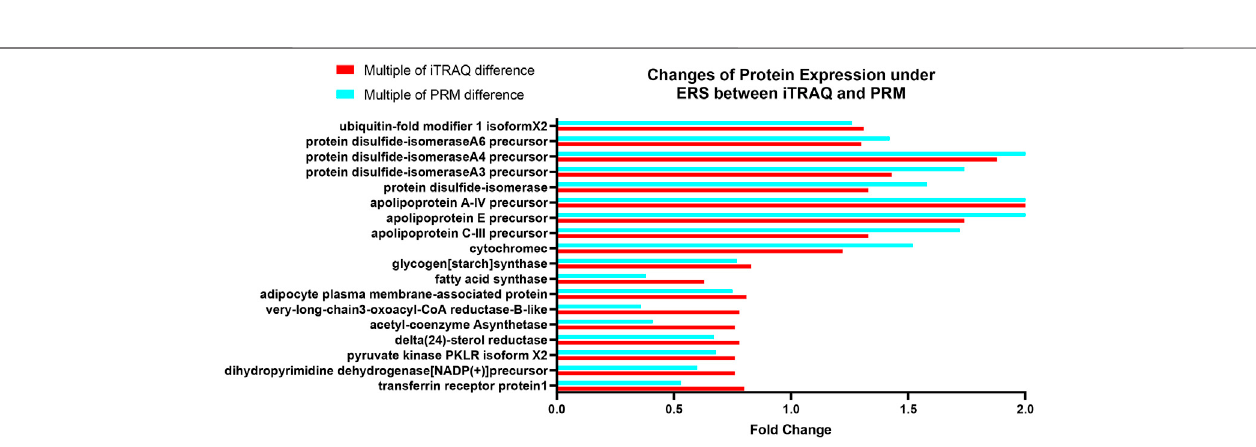
FIGURE 11 | Changes of protein expression under ERS between iTRAQ and PRM bar chart: the horizontal coordinate is the proteins involved in PRM veri fi cation, and the vertical coordinate is the fold change of the protein.